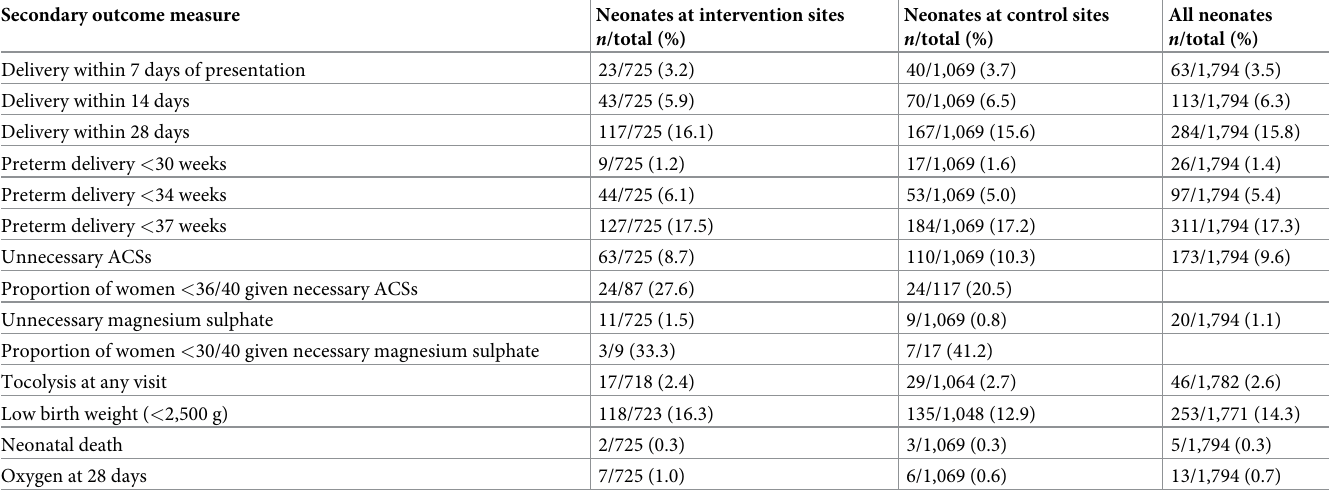
Table 3. Secondary outcomes of neonates at intervention sites using QUiPP app versus control sites using conventional